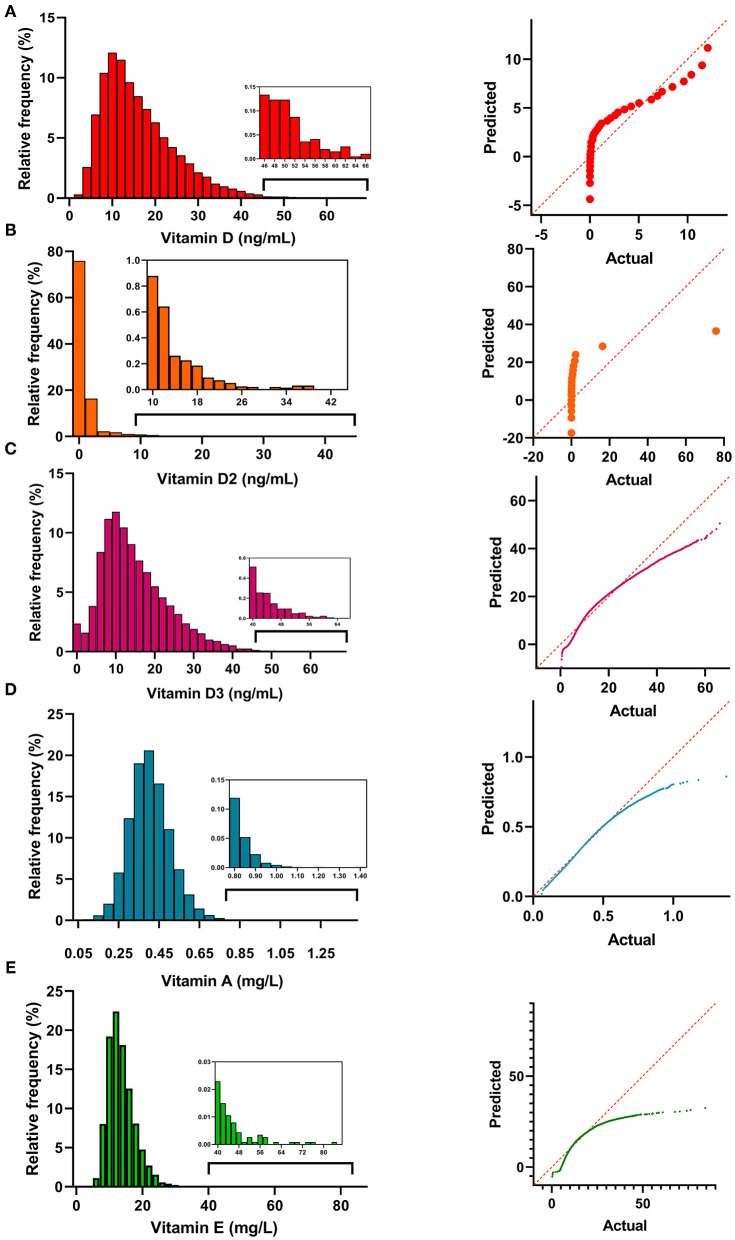
The distribution histograms of vitamin A (A), D2 (B), D3 (C), A (D), and E (E).